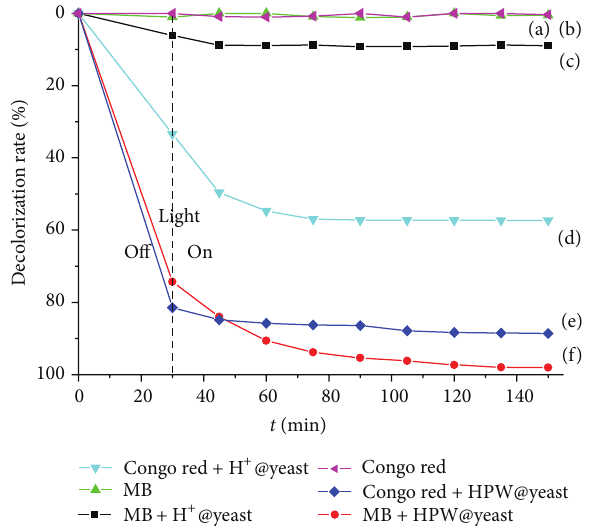
Figure 8: Discolorations reaction of MB and Congo red.